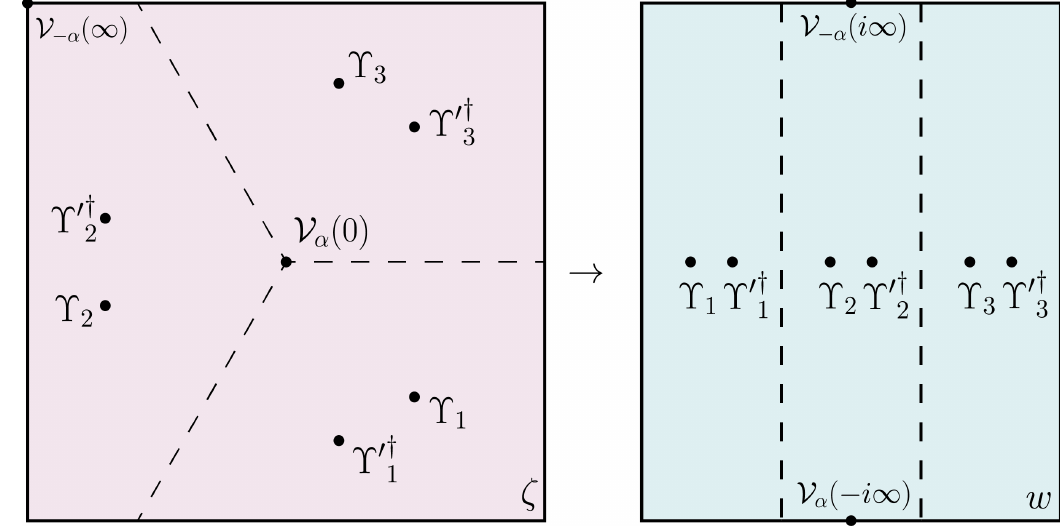
D E Υ Υ 0† V α V − α Q n k k k =1